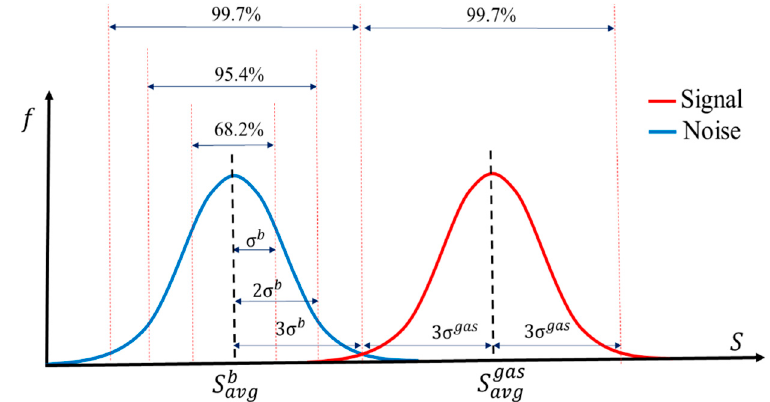
Figure 17. Illustration of the limit of detection (LOD) concept. The concentration corresponding to the lowest detector’s response (red curve) that can be distinguished from the detector’s noise (blue curve) is the LOD. ChemEngineering 2019 , 3 , x FOR PEER REVIEW